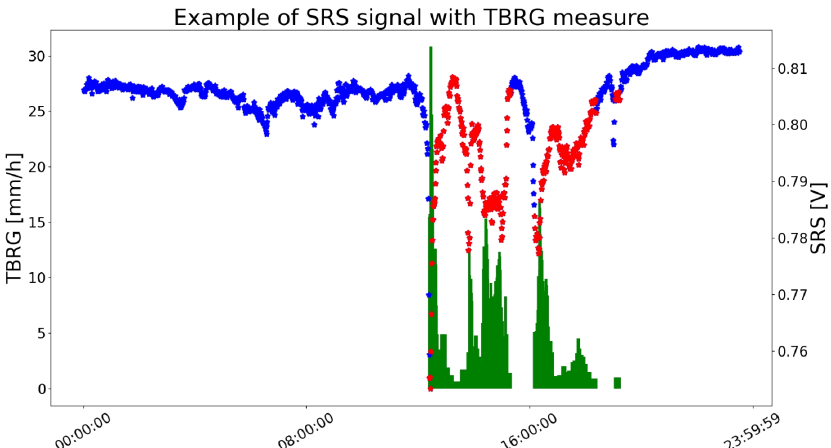
Figure 2. Example of one day signal collected by the SRS system with the TBRG reference. The his- togram in green represents the measurement of the TBRG in mm/h. The dots represent the readings from the SRS system: they are marked in blue when the TBRG output is zero, and they are marked in red